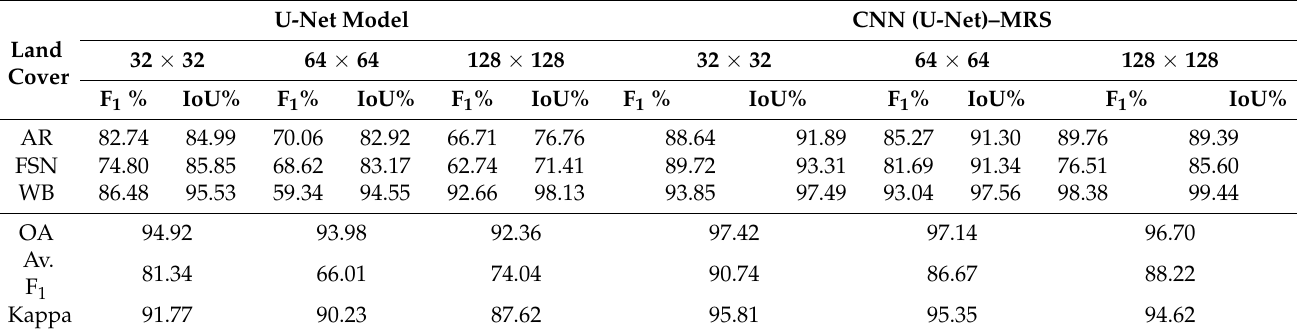
Table 12. Kocaeli test site with 7 bands: performance metrics with U-Net.